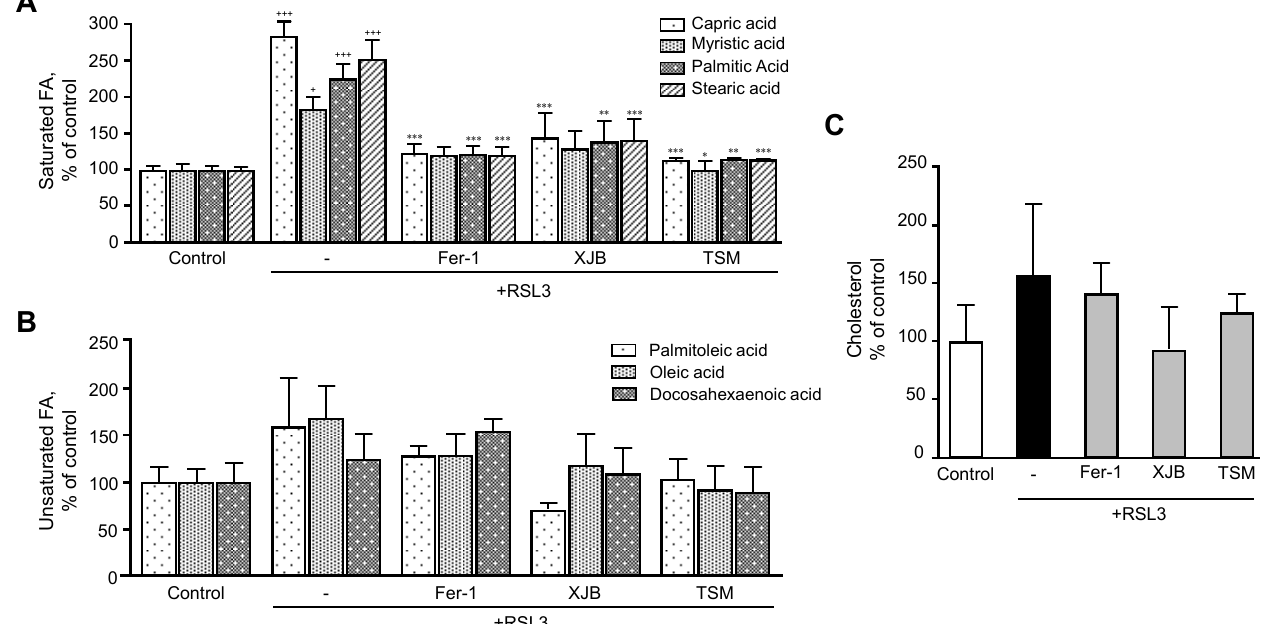
Figure 5. Fatty acids and cholesterol levels after ferroptosis. ( A ) Saturated FA. ( B ) Unsaturated FA. ( C ) Cholesterol. Data are presented as a percentage of the control group. + p < 0.05 and +++ p < 0.001 vs. control; * p < 0.05, ** p < 0.01 and *** p < 0.001 vs. RSL3. n = 4–6 per group.